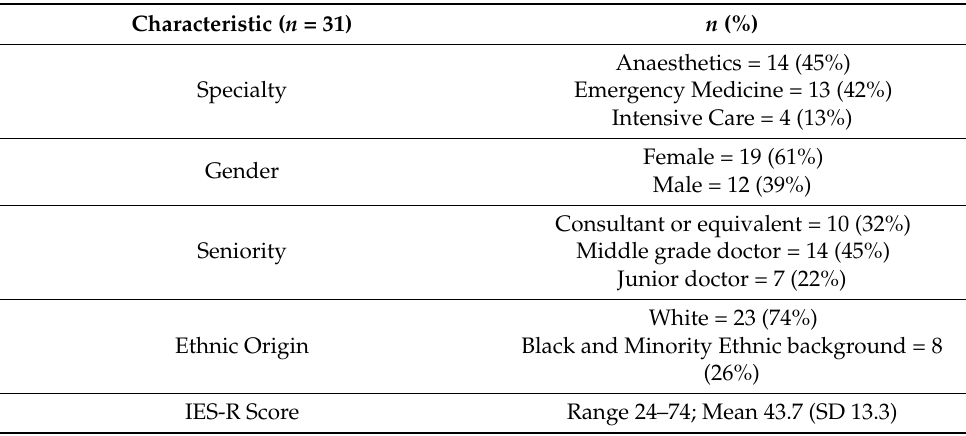
Table 2. Characteristics of the doctors